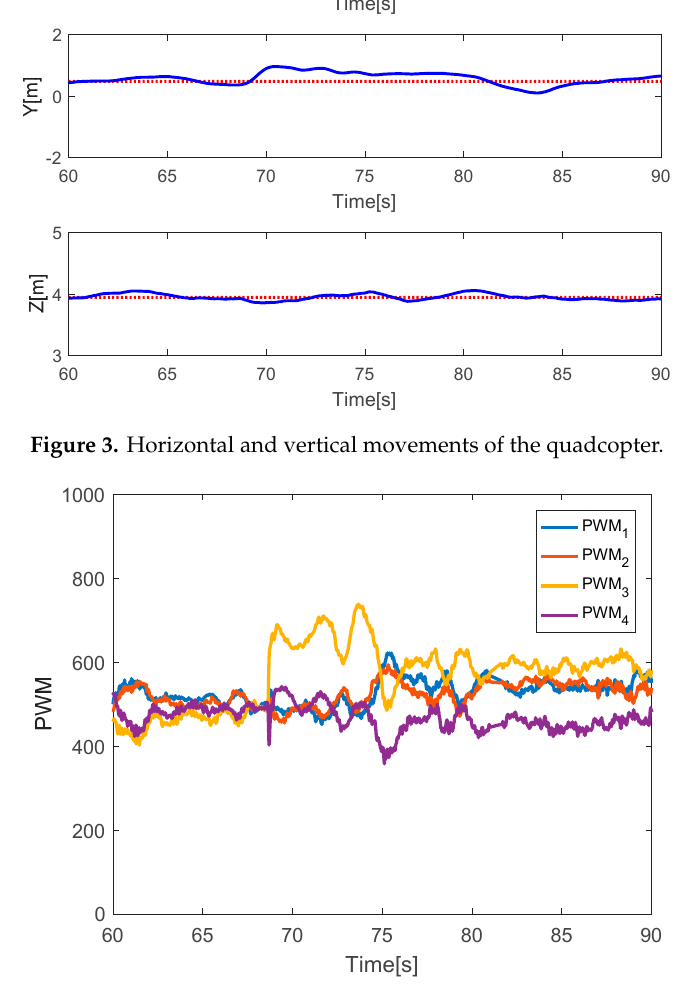
Figure 4. Pulse width modulation (PWM) inputs.